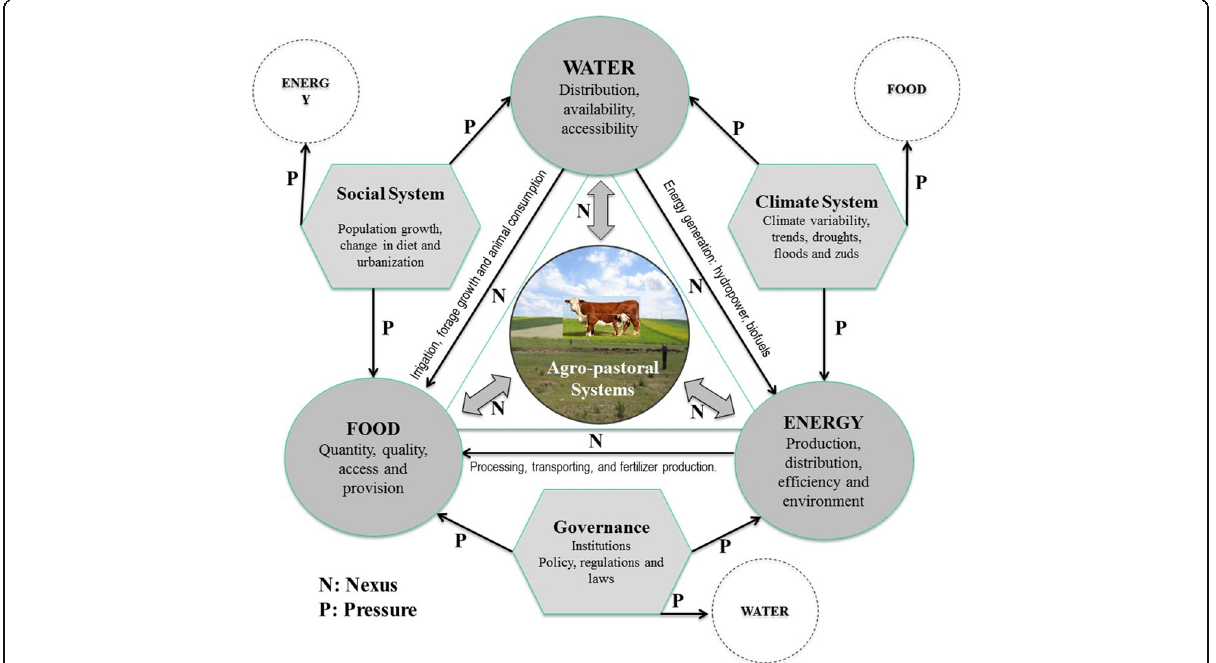
Fig. 4 Agro-pastoral lands are at the center of the nexus of food, energy, and water under increasing climate impacts, human pressures (e.g., land use intensity, cover change), and changing